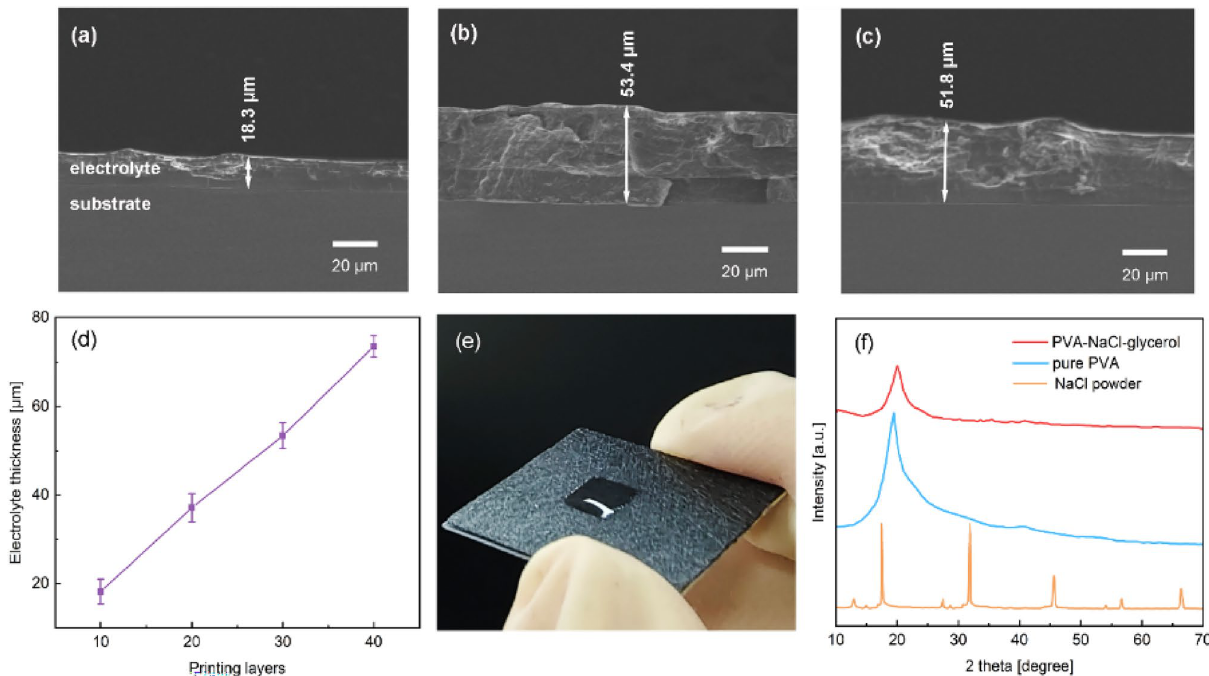
Figure 1. ( a ) Cross-sectional SEM of the electrolyte printed10 layers, ( b ) printed 30 layers non-continuously and ( c ) continuously. ( d ) The thickness of the electrolyte depends on the number of printing layers. ( e ) The photo of the electrolyte prepared by aerosol jet printing. ( f ) XRD patterns of NaCl, PVA and